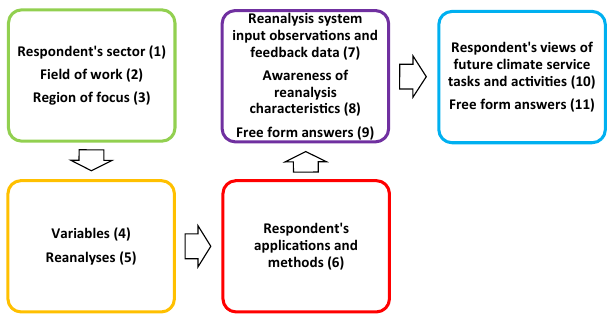
Figure 1. Flowchart of the questionnaire grouped into five main fo- cus areas: respondent’s specific background (green), data (yellow), methods (red), awareness and needs concerning reanalysis proper- ties (purple) and future climate service